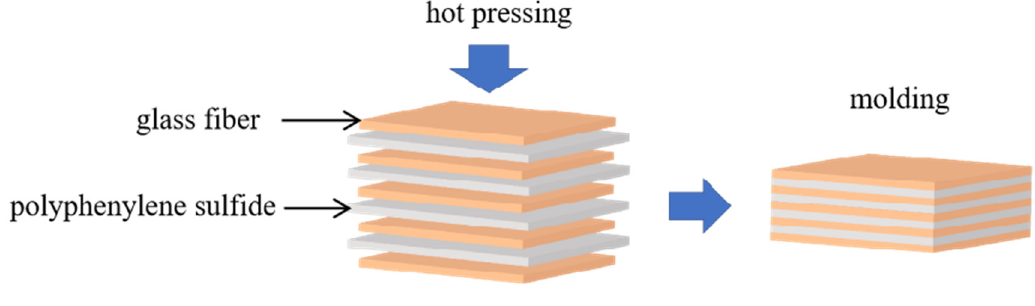
Figure 3. Prefab schematic.